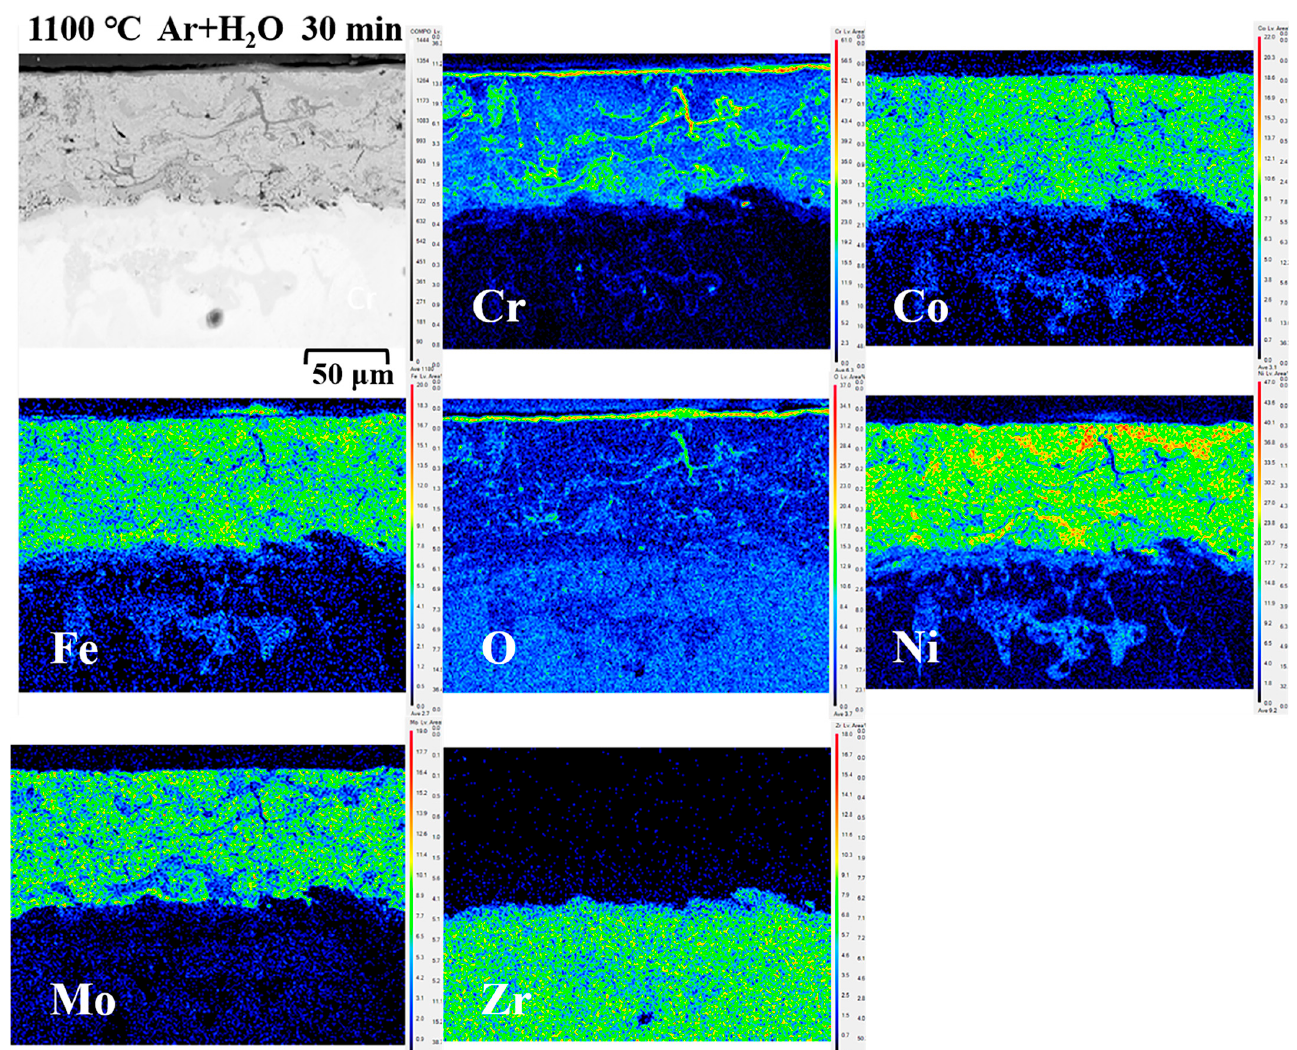
Figure 7. EPMA elemental mapping of the FeCoNiCrMo coatings after 30 min of oxidation at 1100 °C in a steam environment.